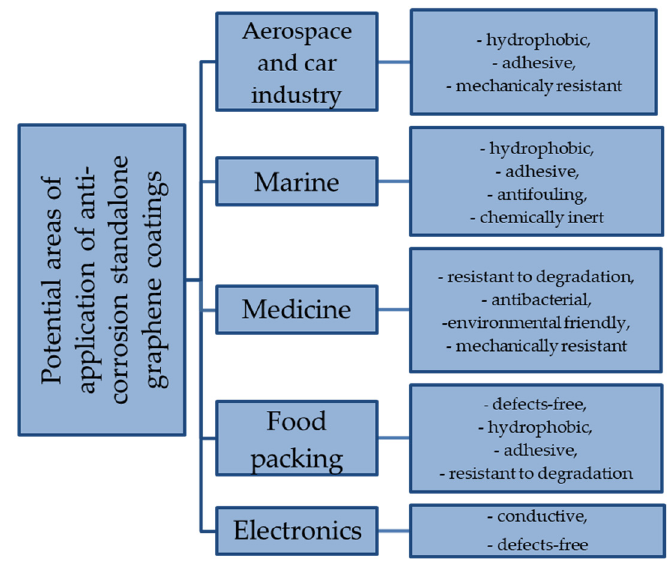
Figure 1. Potential areas of application of anticorrosion standalone graphene coatings.